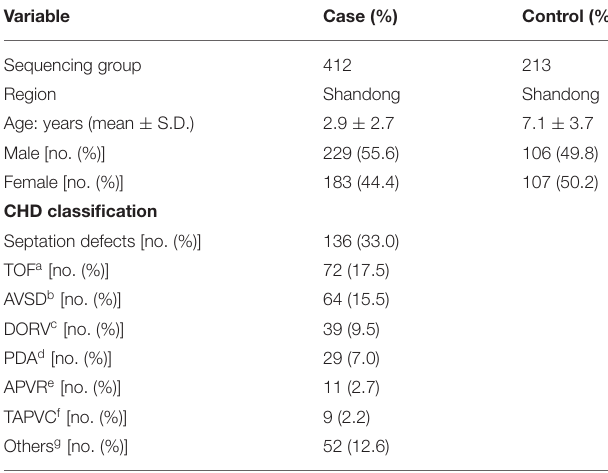
TABLE 1 | Information of CHD cases and